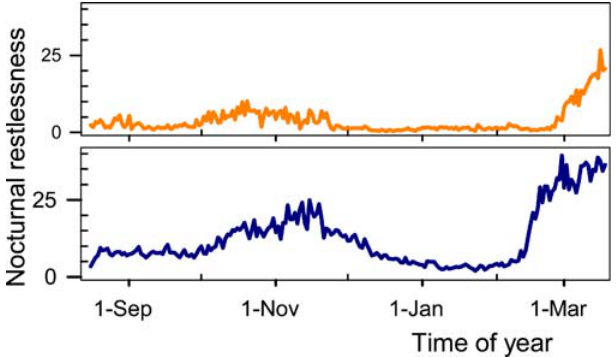
Figure 2. Zugunruhe under European Day Length Conditions Curves show mean nocturnal activity of ten resident African (upper panel, orange line) compared to 26 migrant European (lower panel, blue line) stonechats kept individually for one migration period under simulated natural European day length conditions; for details, see Figure 1. DOI: 10.1371/journal.pbio.0040110.g002